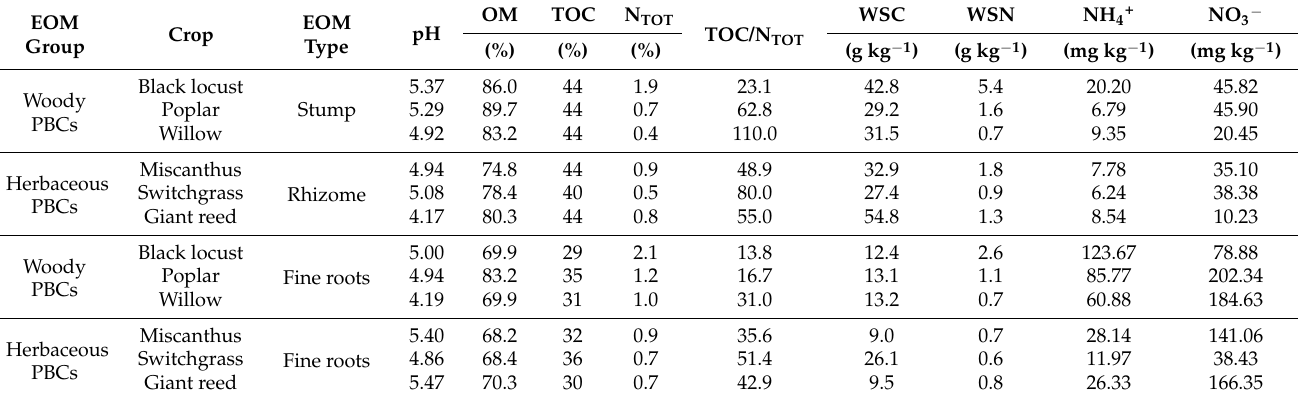
Table 2. Main characteristics of the exogenous organic matter used in the experiment.